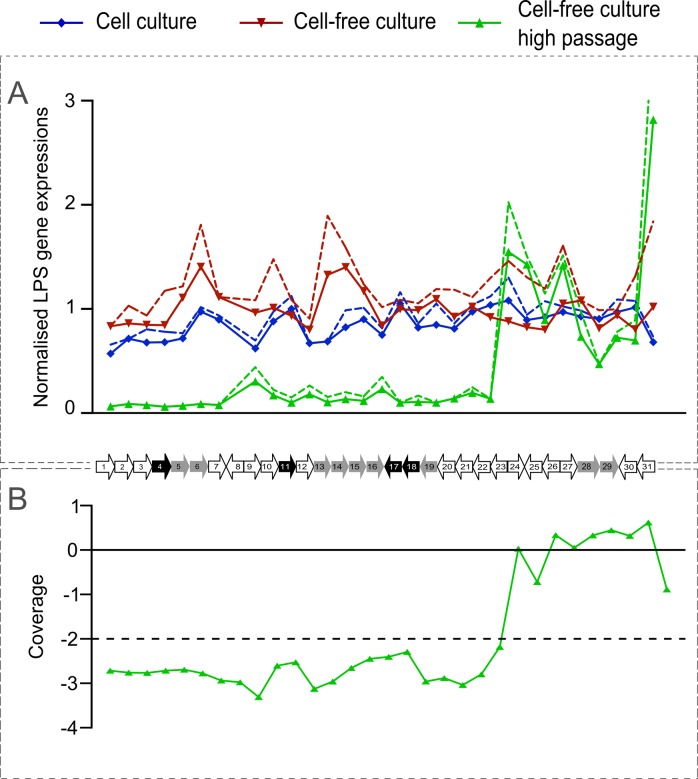
Normalised LPS gene expression profiles and genome coverage of C. burnetii 602 strain as a representative example.A) Here average transcript signal per gene was normalised with the average transcript signal of housekeeping gene rpoB of C. burnetii. The normalised gene expressions are plotted for 602 low passage strain in cell-based and cell-free culture systems and 602 high passaged cell-free culture strain. The dashed lines represent standard deviations from two independent replicates. B) Genomic coverage of genes involved in LPS synthesis of a high passaged cell-free culture 602 strain. A coverage below the minus 2 SD interval (dashed line) was considered as a significantly deleted gene. The x-axis for both the A and B graphs are shown as a scaled mini-map of C. burnetii LPS encoding genes. Each data point represents to its corresponding gene (CBU0676 to CBU0706) labelled as 1 to 31 genes in the gene map. The genes indicated in grey are hypothesized to be involved O-antigen synthesis and export. Genes indicated in black are hypothesized to be involved in other LPS synthesis steps and carbohydrate metabolism.